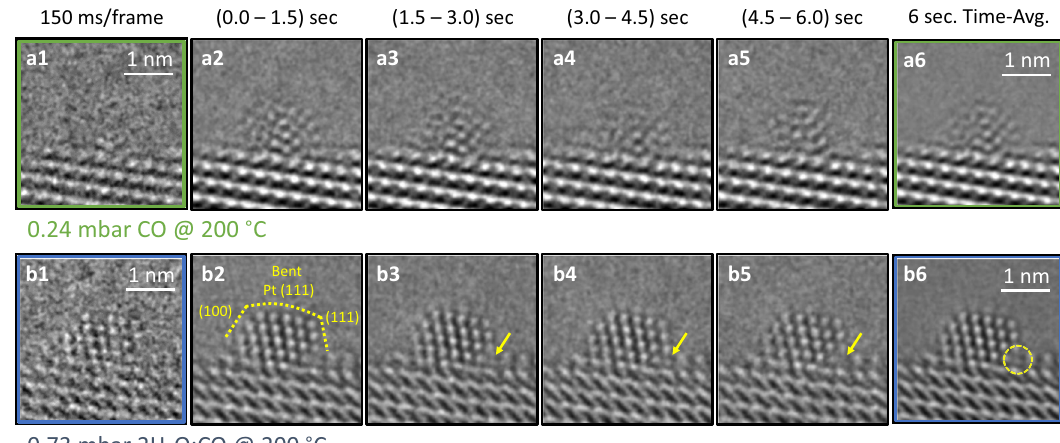
Fig. 2 Dynamic structural response and behavior of the Pt/CeO 2 catalyst. a1 – a6 Images of the Pt/CeO 2 catalyst at 200 °C in CO gas. b1 – b6 Images of the Pt/CeO 2 catalyst at 200 °C in WGS reaction conditions. a1 / b1 shows the catalyst (close to the mean size of 1.7 nm) in a single 150 millisecond frame (ms/frame). Time-averaged image series from sequential 1.5 s intervals are shown in Figs. a2 – a5 and b2 – b5. The CeO 2 -supported Pt nanoparticle adopts a bent, facetted morphology in the WGS condition, which is highlighted by the dashed outline and facet labels. Dynamic structural fl uctuations are seen at perimeter sites as indicated by the yellow arrow. a6 / b6 show the time-averaged image over the entire 6 s movie for each condition. The corresponding in situ TEM movies can be found in Supplementary Movie 1 and 2. The same Pt nanoparticle is shown in all frames. The behavior exhibited by the Pt nanoparticle in Fig. 2 is typical of the many observed during the in situ TEM experiment. Additional images from a different particle, for example, are shown in Supplementary Fig.